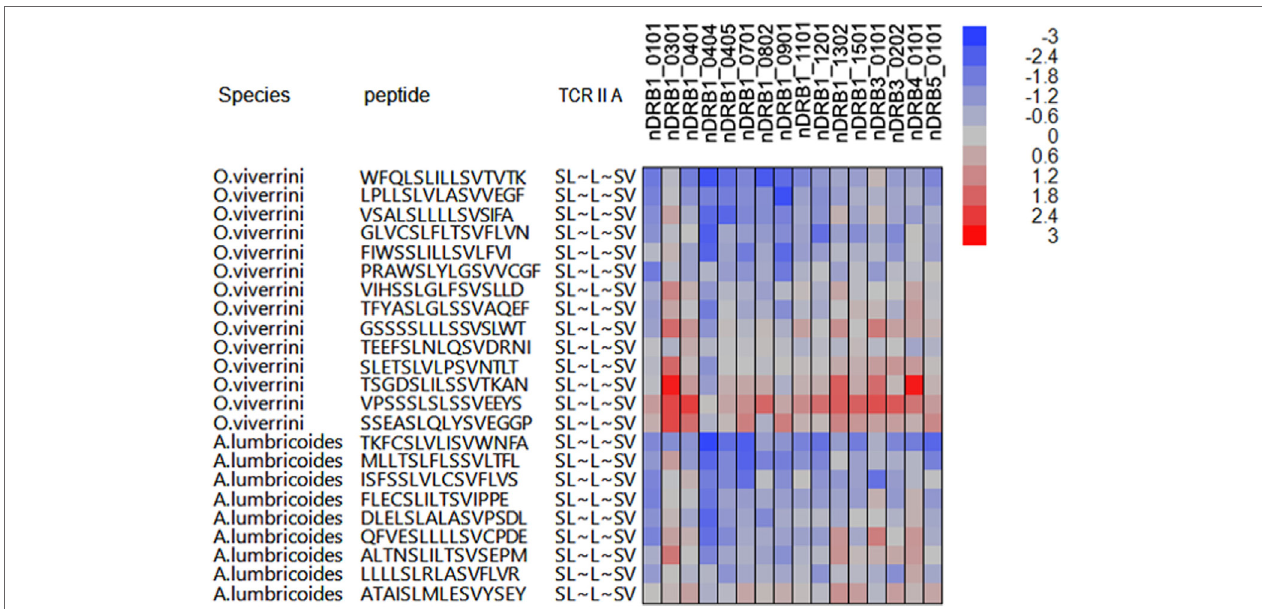
FigUre 3 | Example of peptides of Opisthorchis viverrini and Ascaris lumbricoides , which have shared T-cell-exposed motifs (TCEMs) but in the context of differing groove-exposed motifs. X -axis of cell plot indicates multiple different major histocompatibility complex (MHC) II DRB alleles. Coloration of the cell plot indicates predicted binding affinity in standard deviation units below the mean for that protein. Blue indicates high binding affinity; red indicates low affinity. The peptides represent a range of suppressive indices: O. viverrini ranges from 621,829 to 20,788 and A. lumbricoides from 371,273 to 36,698 based on binding to all MHC II alleles evaluated. As the TCEM motif SL~L~LV is a common motif (FC3), these are all relatively high